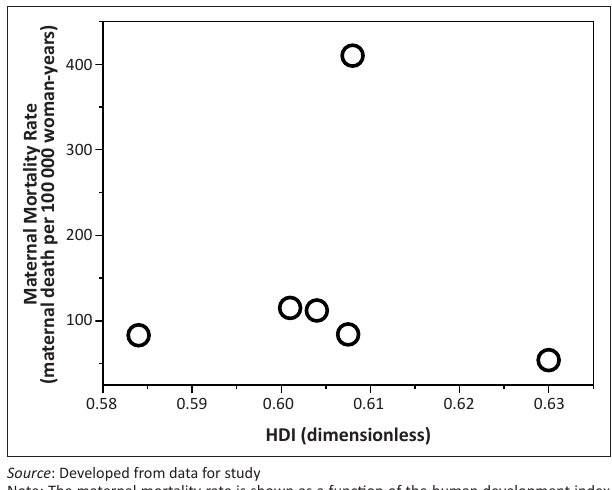
FIGURE 1: The life-expectancy-at-birth inequality index (LEABI) versus the Human Development Index (HDI).